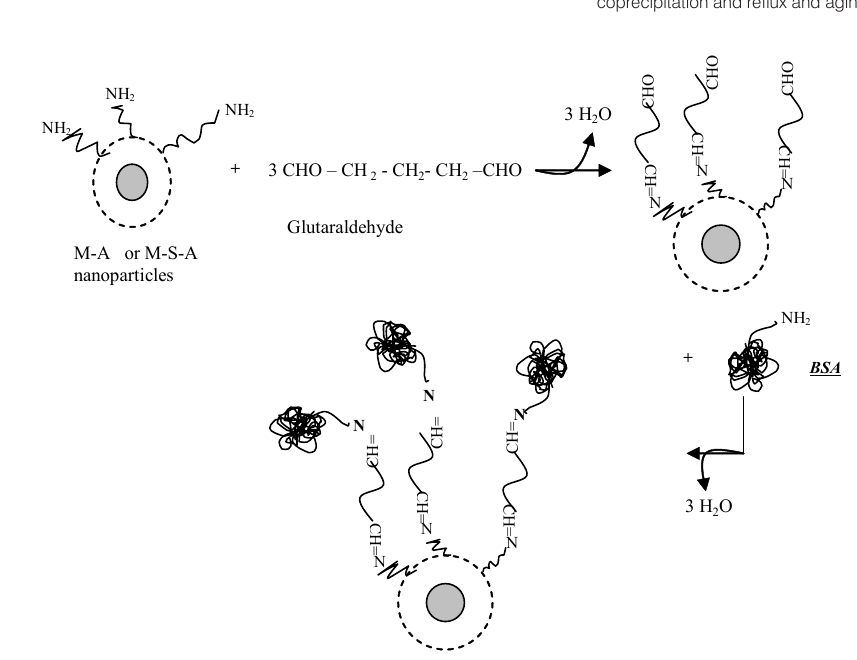
Figure 5. Saturation magnetizations of coated and uncoated magnetite nanoparticles.